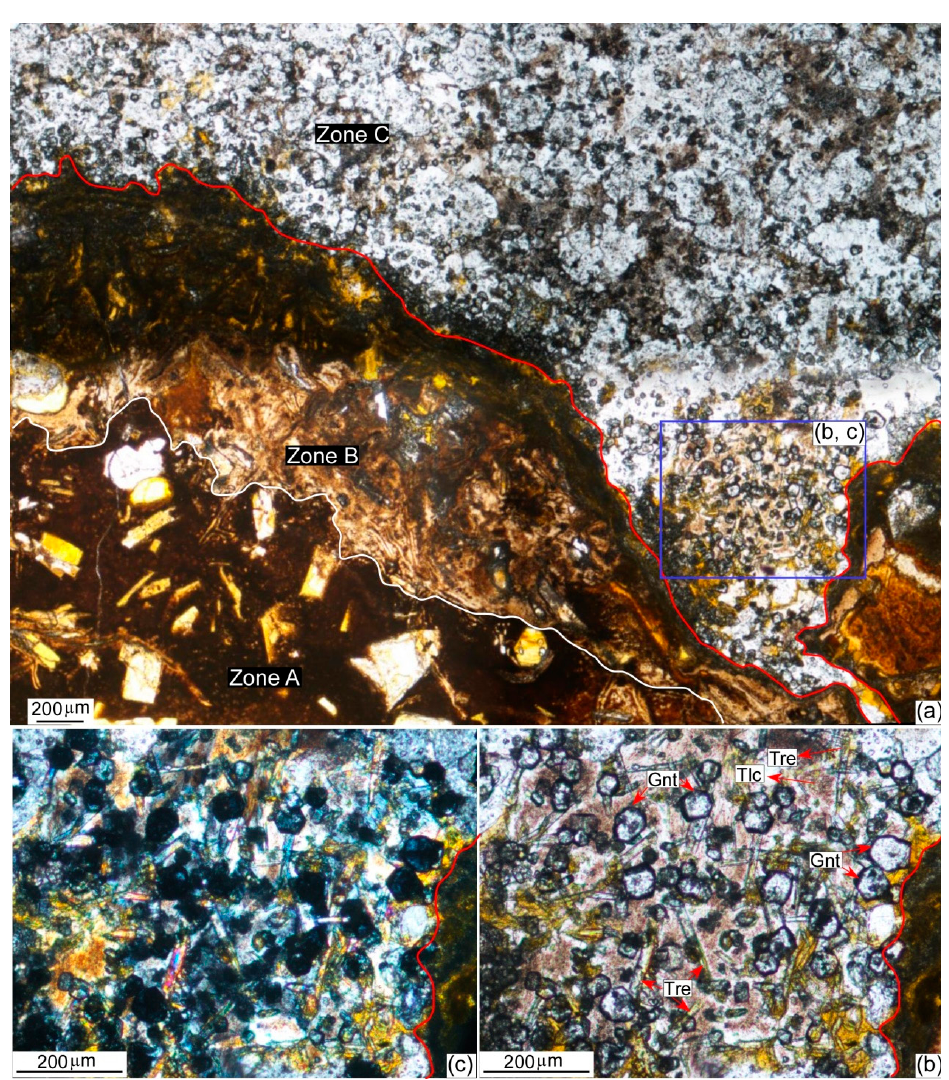
Figure 11. ( a ) Photomicrograph showing the development of metasomatized and metamorphic zones (zones B and C, respectively) in contact with the vitrophyric basalt (zone A). ( b ) Plane Polarized Light (PPL) and ( c ) Crossed Polarized Light (XPL) of inset (b,c) in (a) showing the growth of the metamorphic assemblage tremolite (Tre) and talc (Tlc), and the metasomatic garnet (Gnt) in zone C.